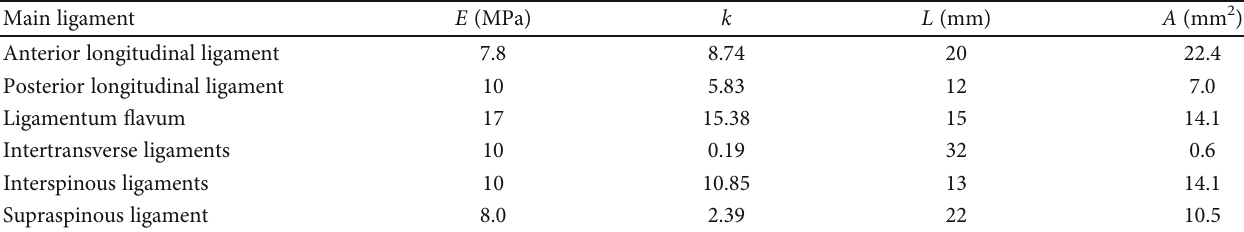
Table 2: The structural attributes of the major ligaments in the thoracolumbar sacral spine. Main ligament